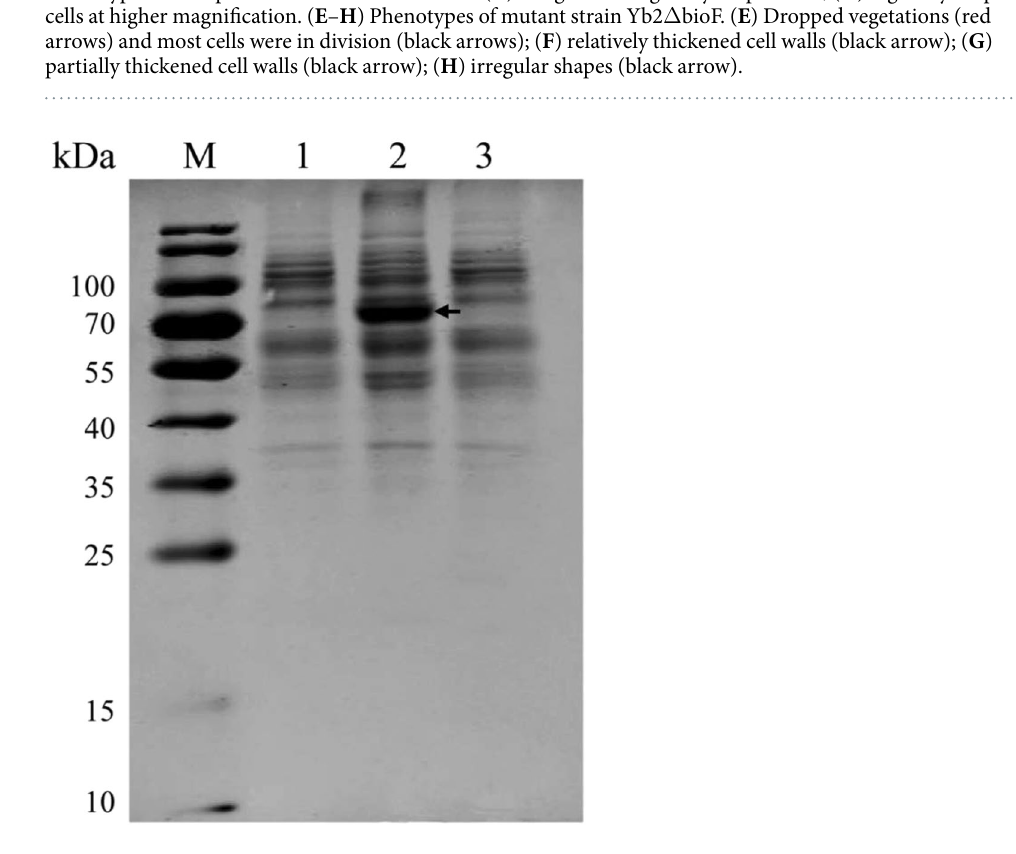
Figure 7. Analysis of membrane proteins. Lane M, weight marker, lane 1, samples from the wild-type strain Yb2, lane 2, samples from the mutant strain Yb2 Δ bioF, lane 3, samples from the complemented strain cYb2 Δ bioF. The arrow indicates the band appeared only in the mutant strain Yb2 Δ bioF. The full-length gel is presented in Supplementary Figure